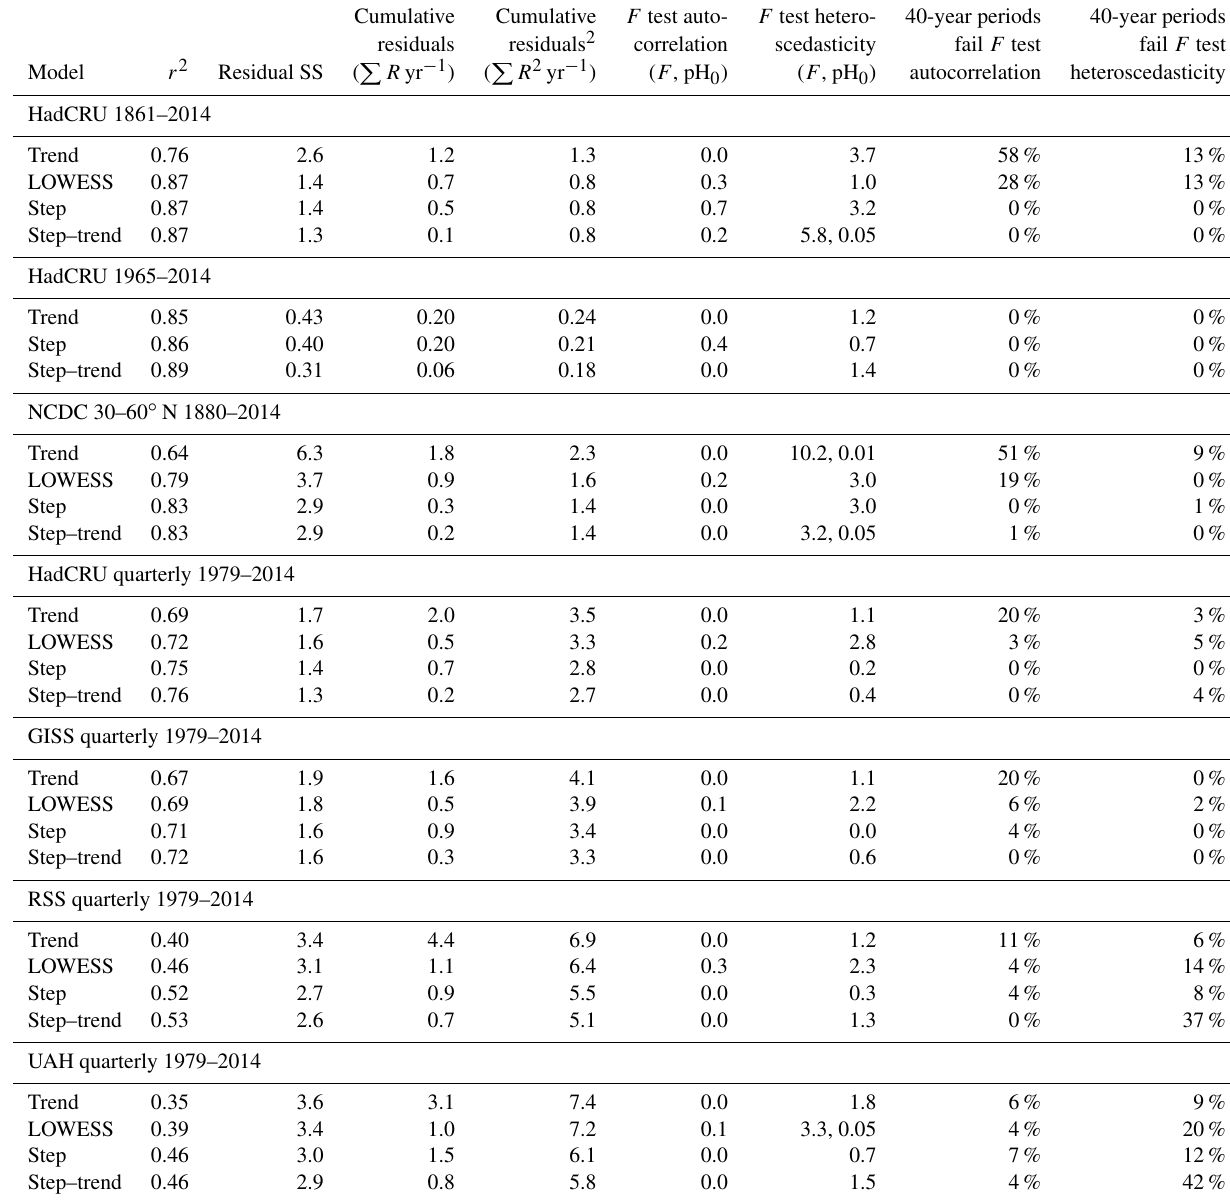
Table 4. Results of eight tests on four statistical models for selected observed global temperature data (except where noted). The statistical models tested are trends (power shown), LOWESS (0.5 total series smoothing), steps, and steps and trends. Results include the adjusted r 2 value, the residual sum of squares (SS), cumulative residuals and squared cumulative residuals. F tests for the whole series are shown, with p <0.05 and p <0.01 noted if registered, otherwise p >0.05. F test failure for 40-year period autocorrelation and heteroscedasticity is measured at p